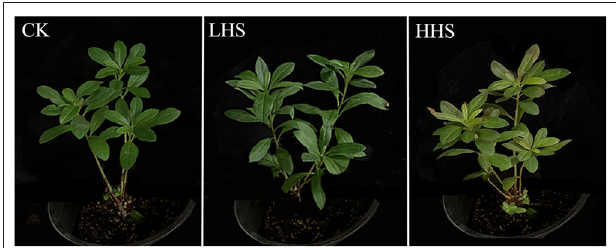
FIGURE 1 | Plants condition after 6 days of different temperature treatment. CK, control (25/20 ◦ C); LHS, light heat stress (35/30 ◦ C); HHS, high heat stress (40/35 ◦